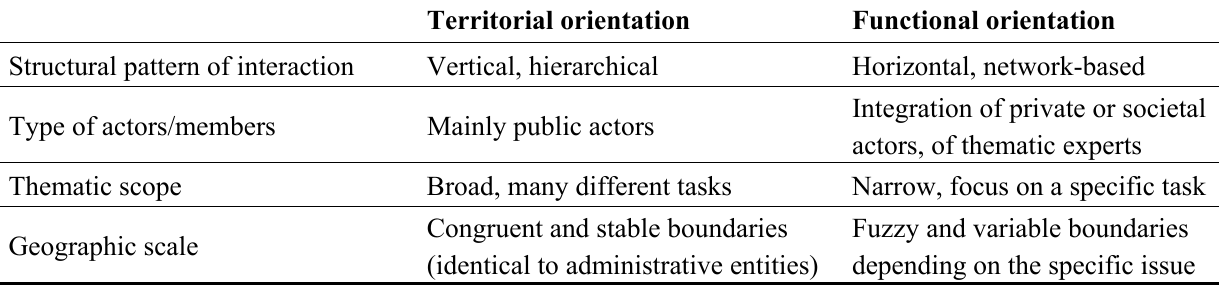
Table 1. Territorial versus functional orientation of cross-border organizations.